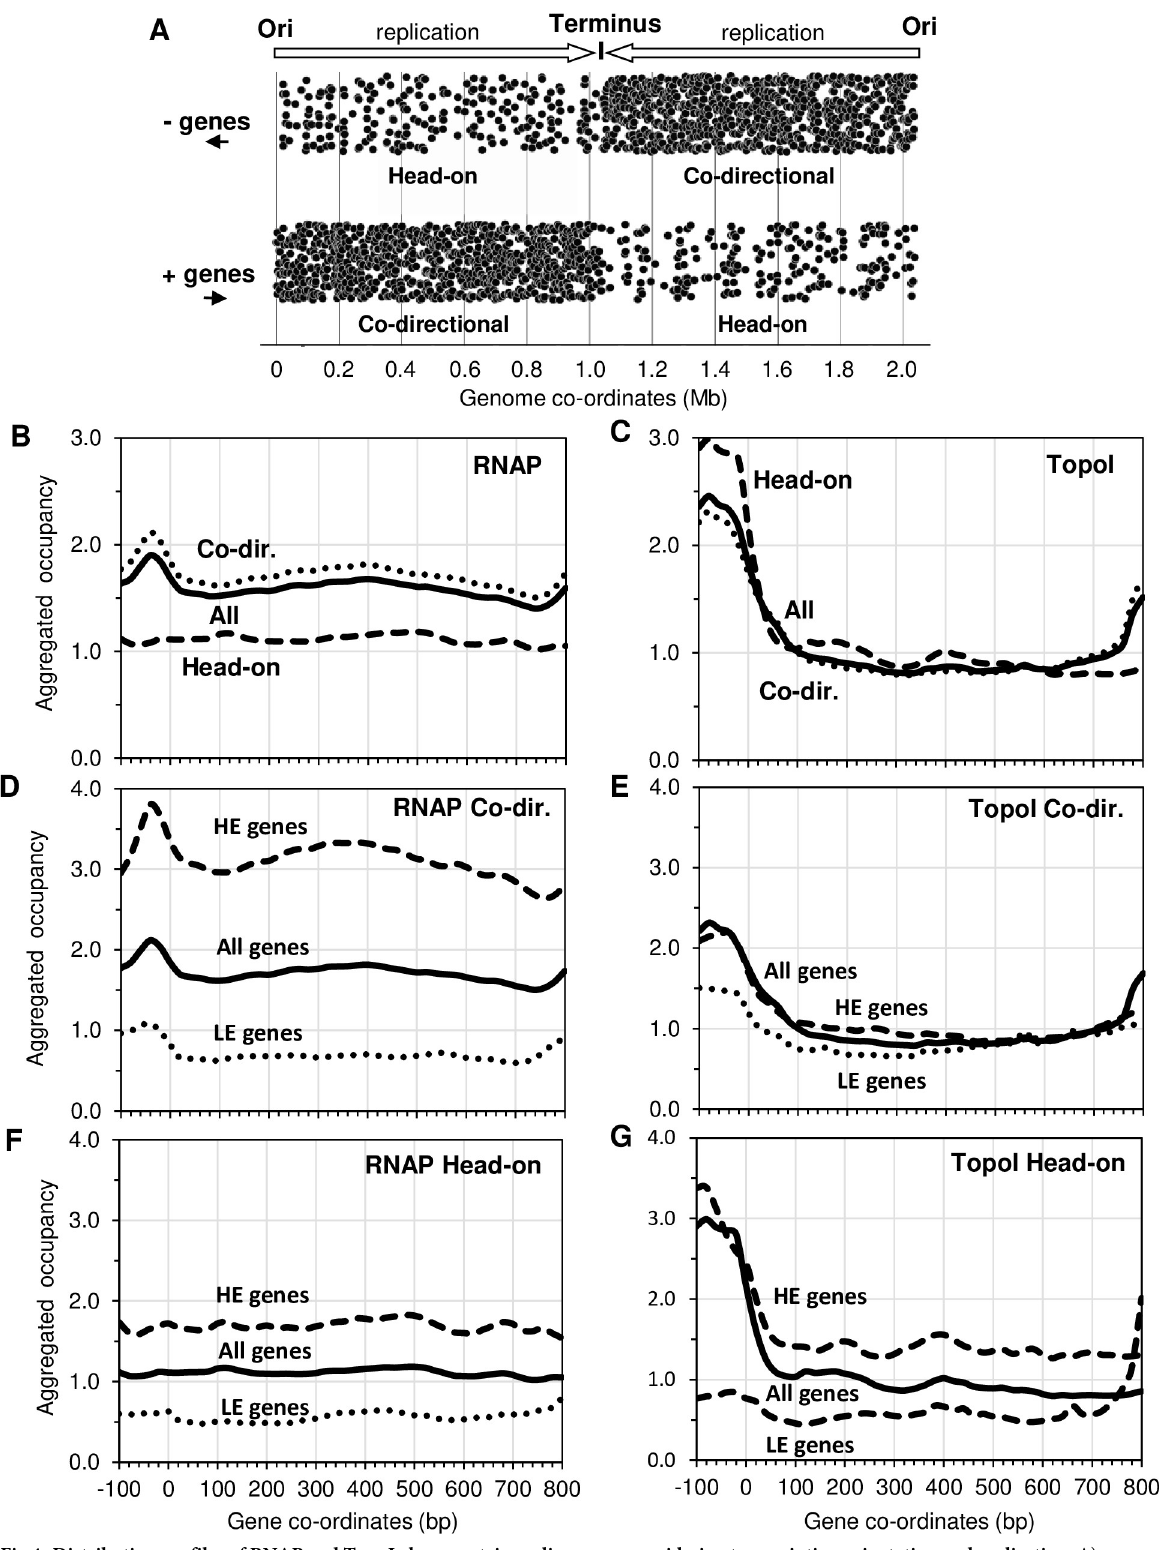
Fig 4. Distribution profiles of RNAP and TopoI along protein-coding genes considering transcription orientation and replication. A) Location of genes in the genome depending of its transcription orientation in relation with replication from the origin (Ori) to the